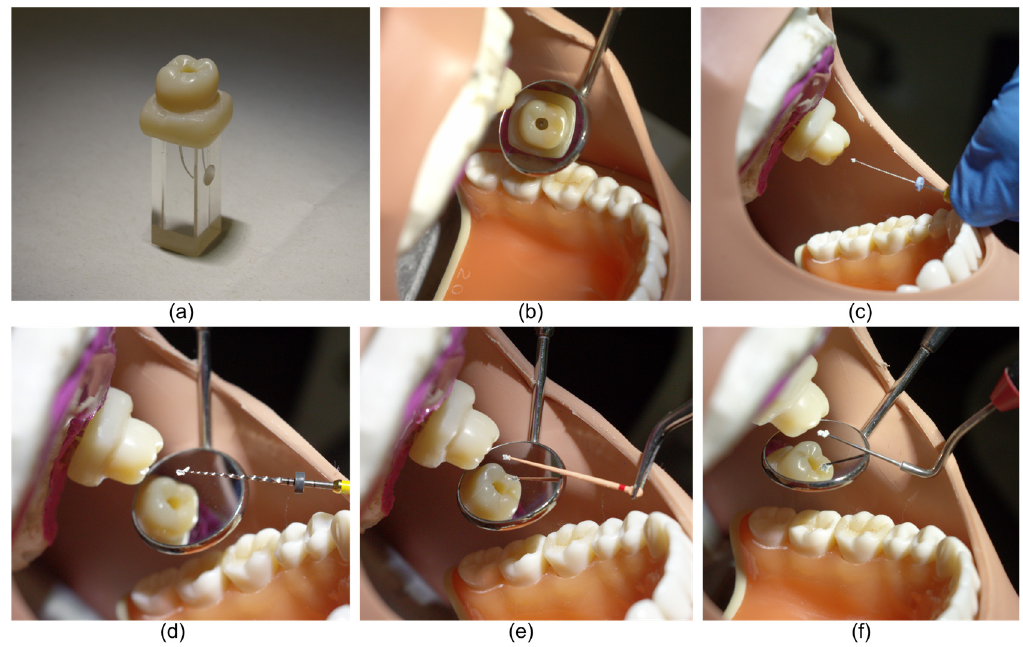
Figure 1. Experimental design: ( a ) acrylic block used with a custom-made composite resin crown; ( b ) acrylic block model after placement in the maxillary tooth mould of the phantom head; ( c ) MTA delivered to the canal using a hand file; ( d ) MTA placed into the canal using a rotary file (ProTaper Gold ® F2 not used in image); ( e ) MTA canal delivery using a GP point; and ( f ) MTA transferred to the canal using a plugger.